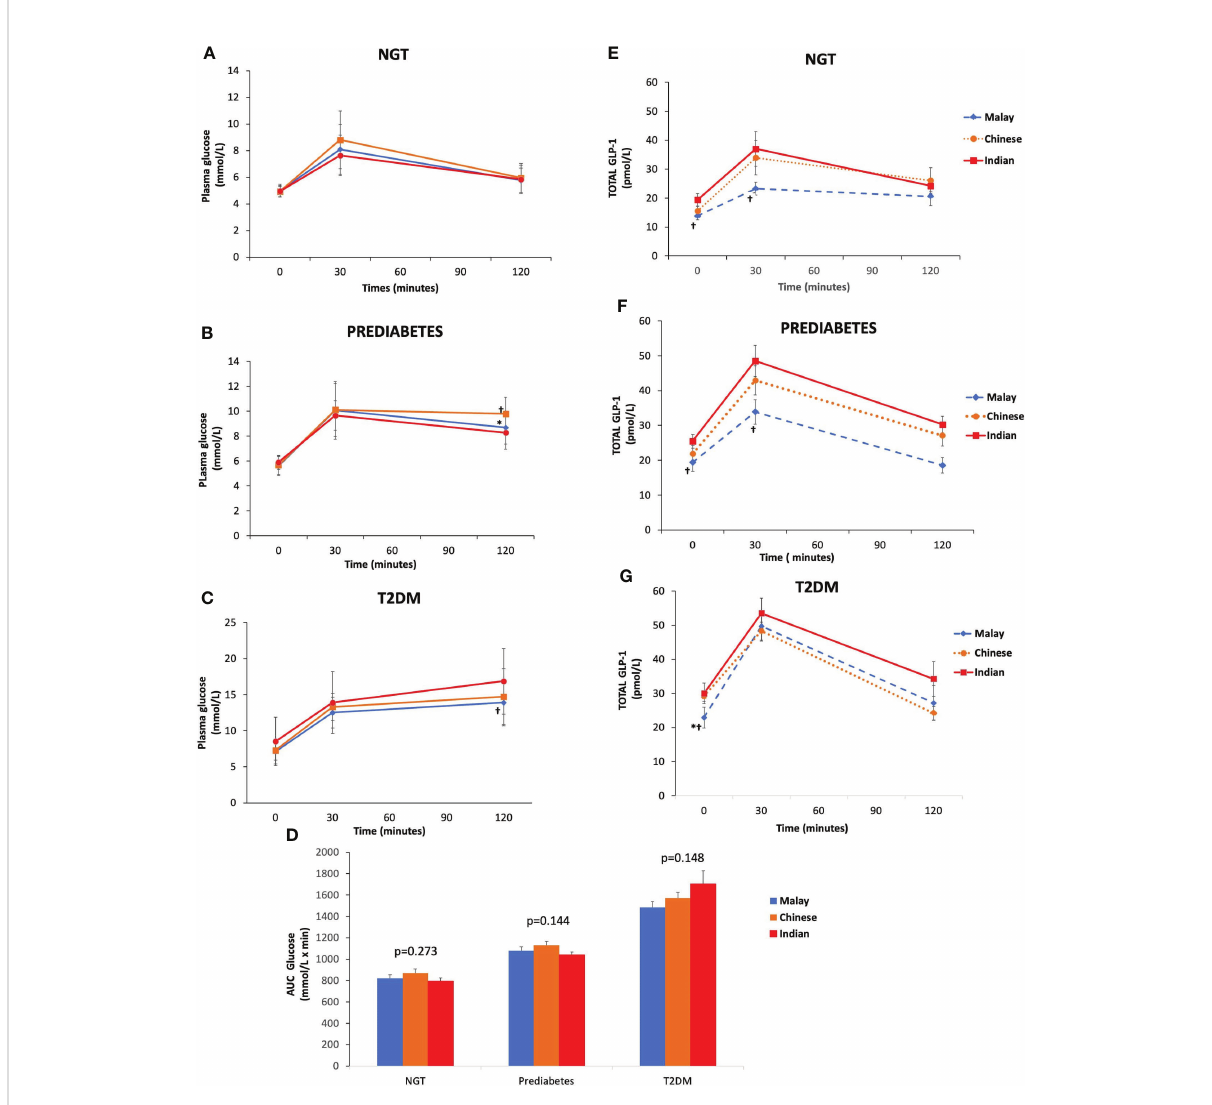
FIGURE 3 Time courses for plasma concentrations of glucose and glucagon-like peptide-1 (GLP-1) during an OGTT by glucose tolerance states. Data are expressed as mean ± SD for (A – C) glucose levels and (D) AUC Glucose and (E – G) total GLP-1 levels. *p < 0.05 versus Chinese, ƚ p < 0.05 versus Indians. AUC, area under the curve; NGT, normal glucose tolerance; T2DM, type 2 diabetes